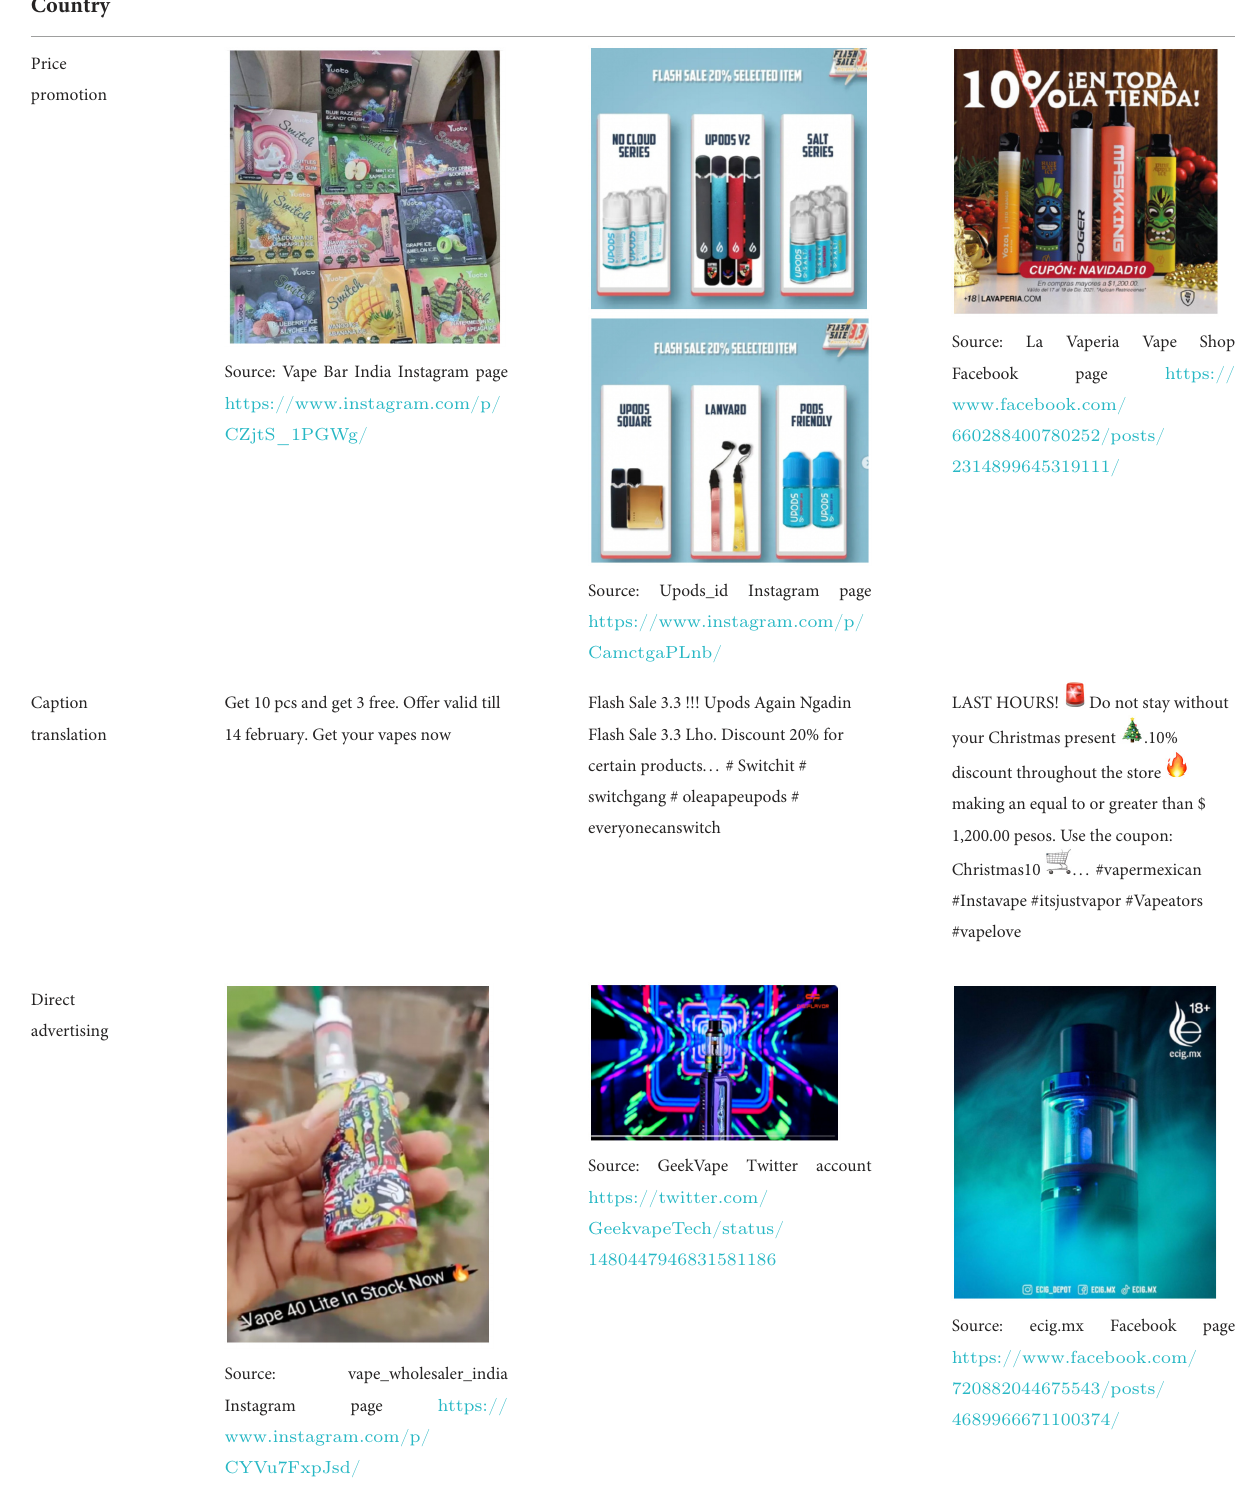
TABLE 2 Examples of e-cigarette marketing tactics observed in India, Indonesia, and Mexico. Marketing Tactic |